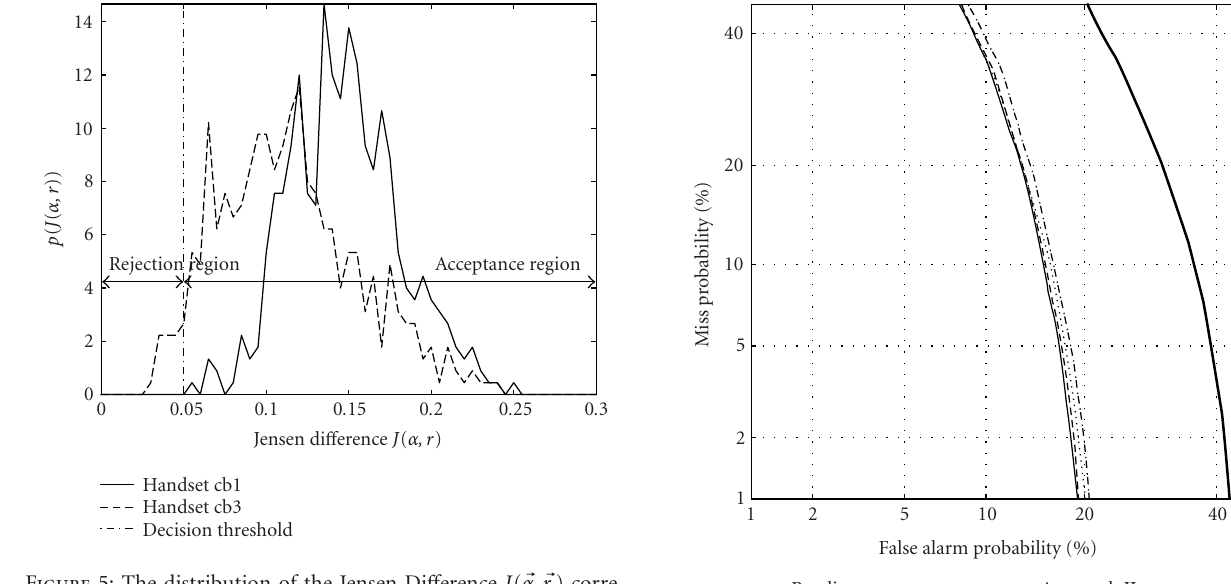
column cb3. Again, the slight discrepancy between the mea- sured EERs and the EERs in Table 5 is due to interpolation error.